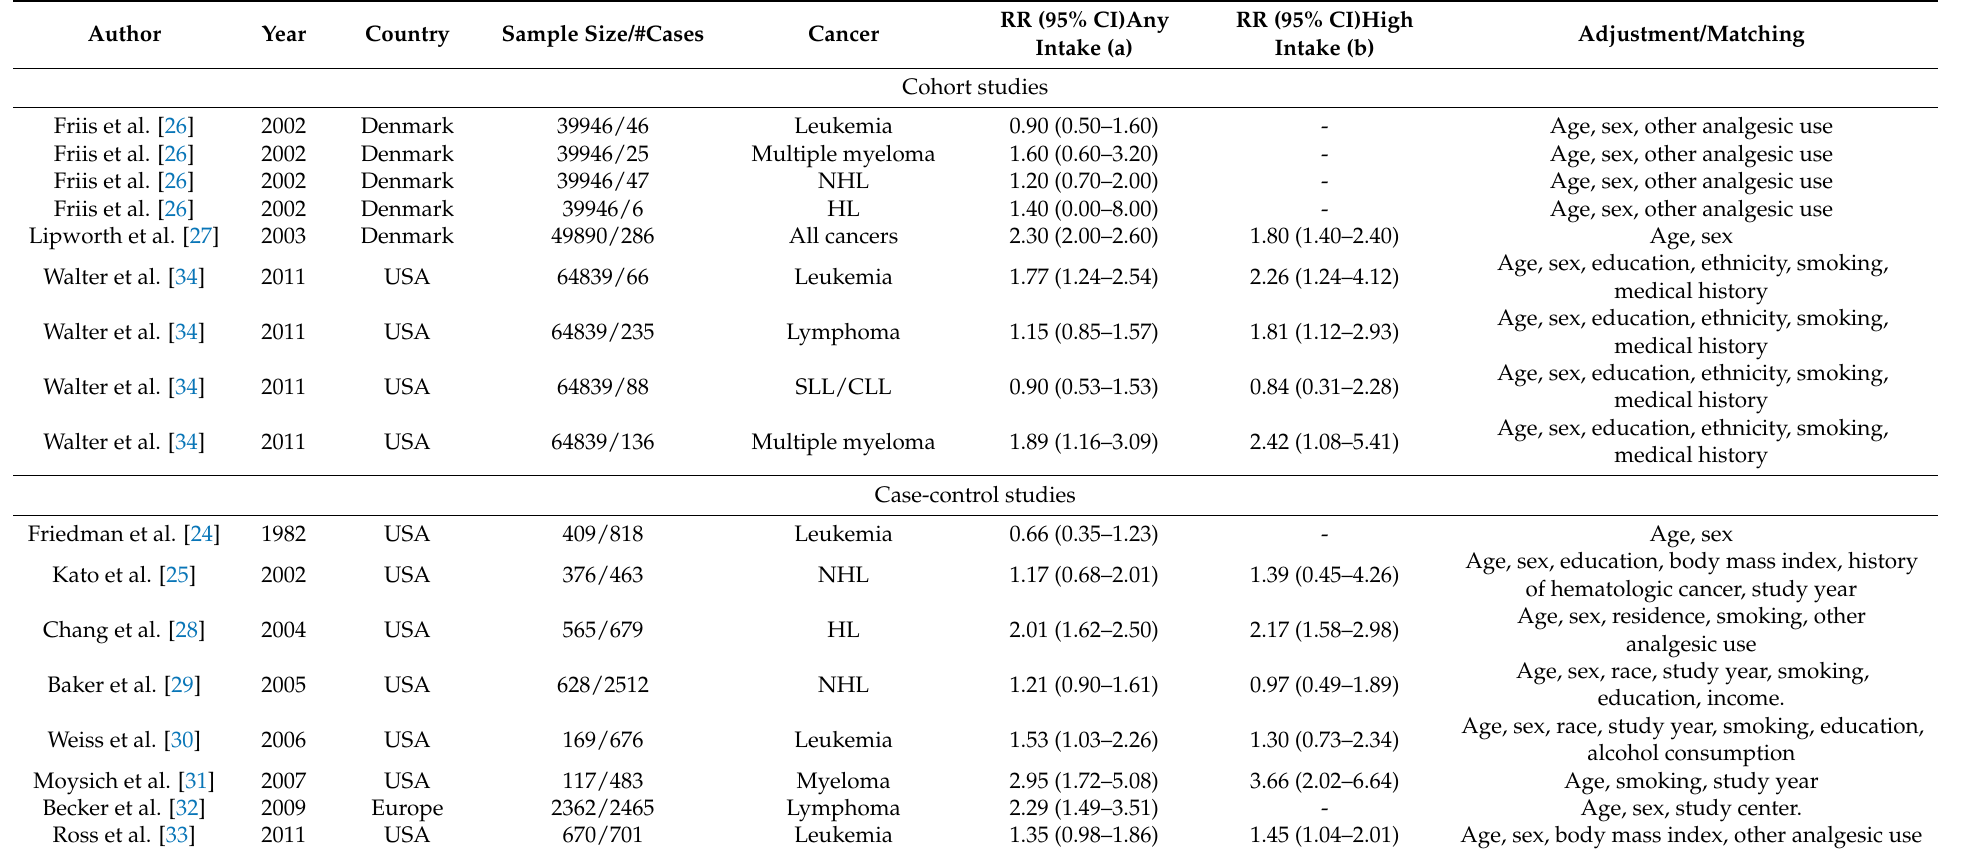
Table 2. Odds ratios of paracetamol intake and hematologic malignancies in individual